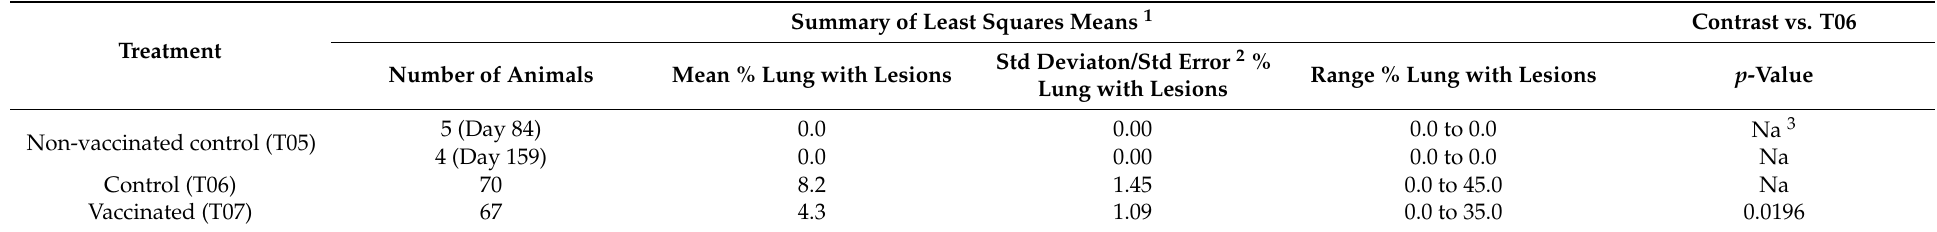
Table 6. Least squares means and significance values for Mhyo -consistent macroscopic lung